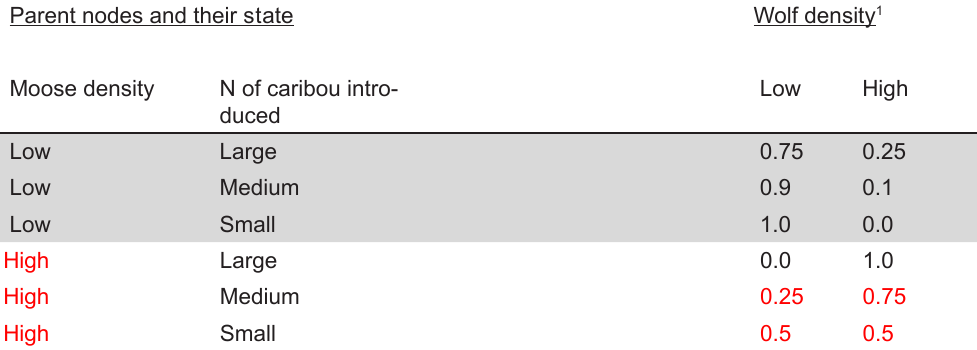
Table A7. Conditional probability table for node wolf